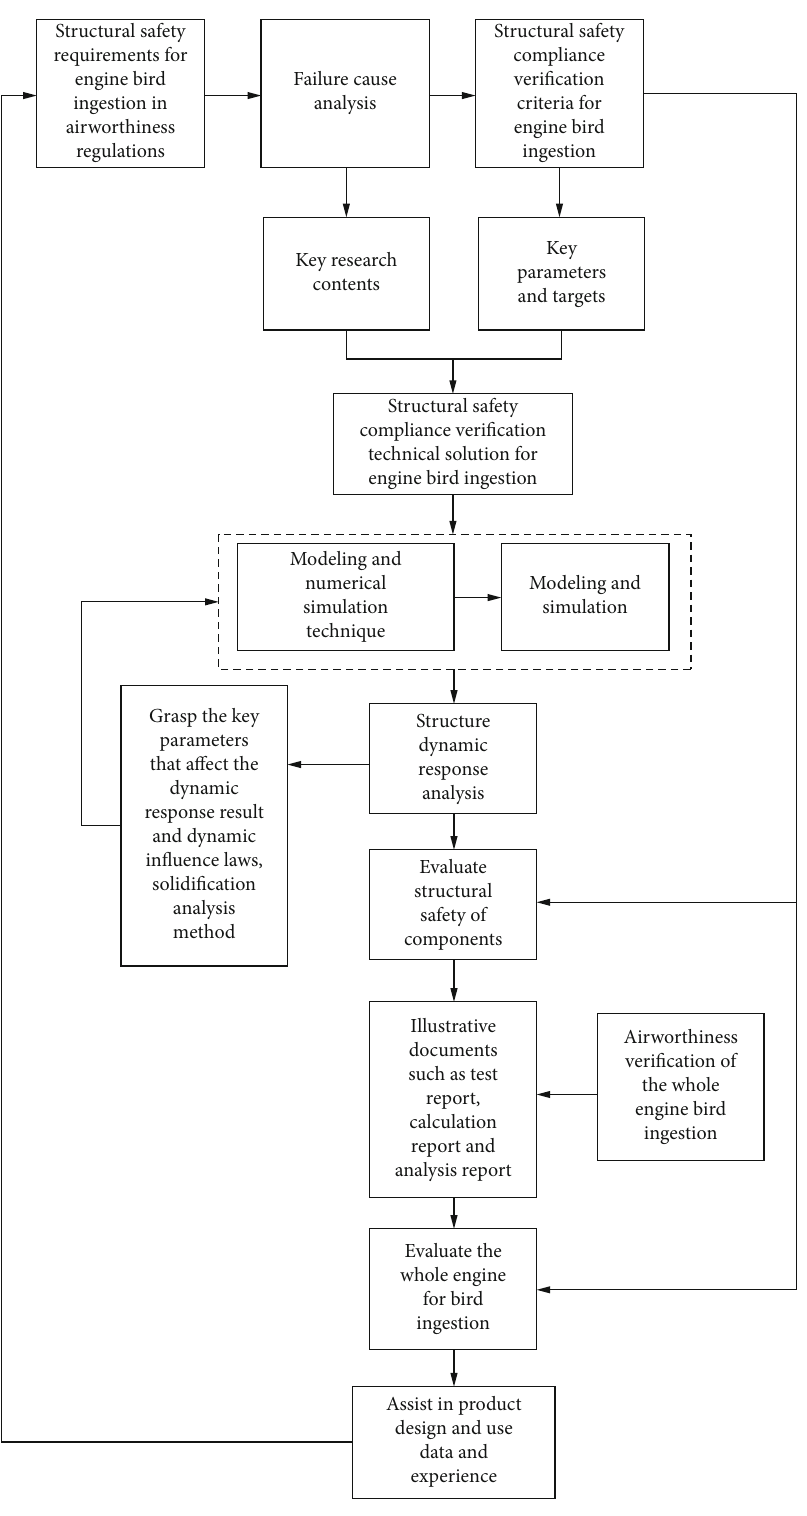
Figure 2: MC2 compliance veri fi cation method fl